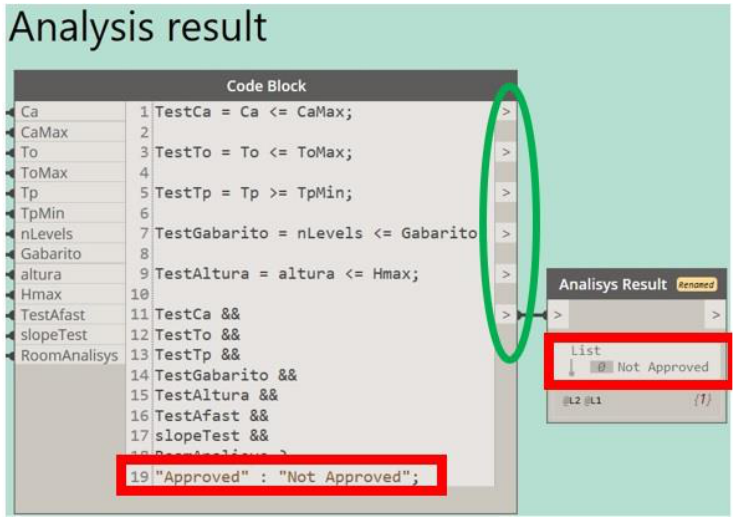
Figure 9. SF building analysis result.